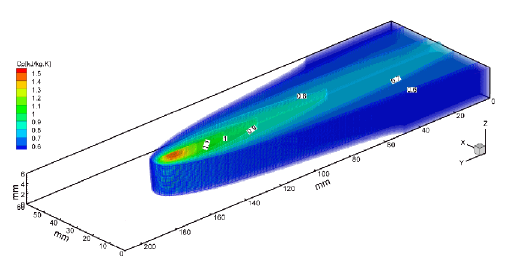
Figure 12. Grain size evolution resulted after the finishing welding pass (heat input =1.2 kJ mm -1 ).